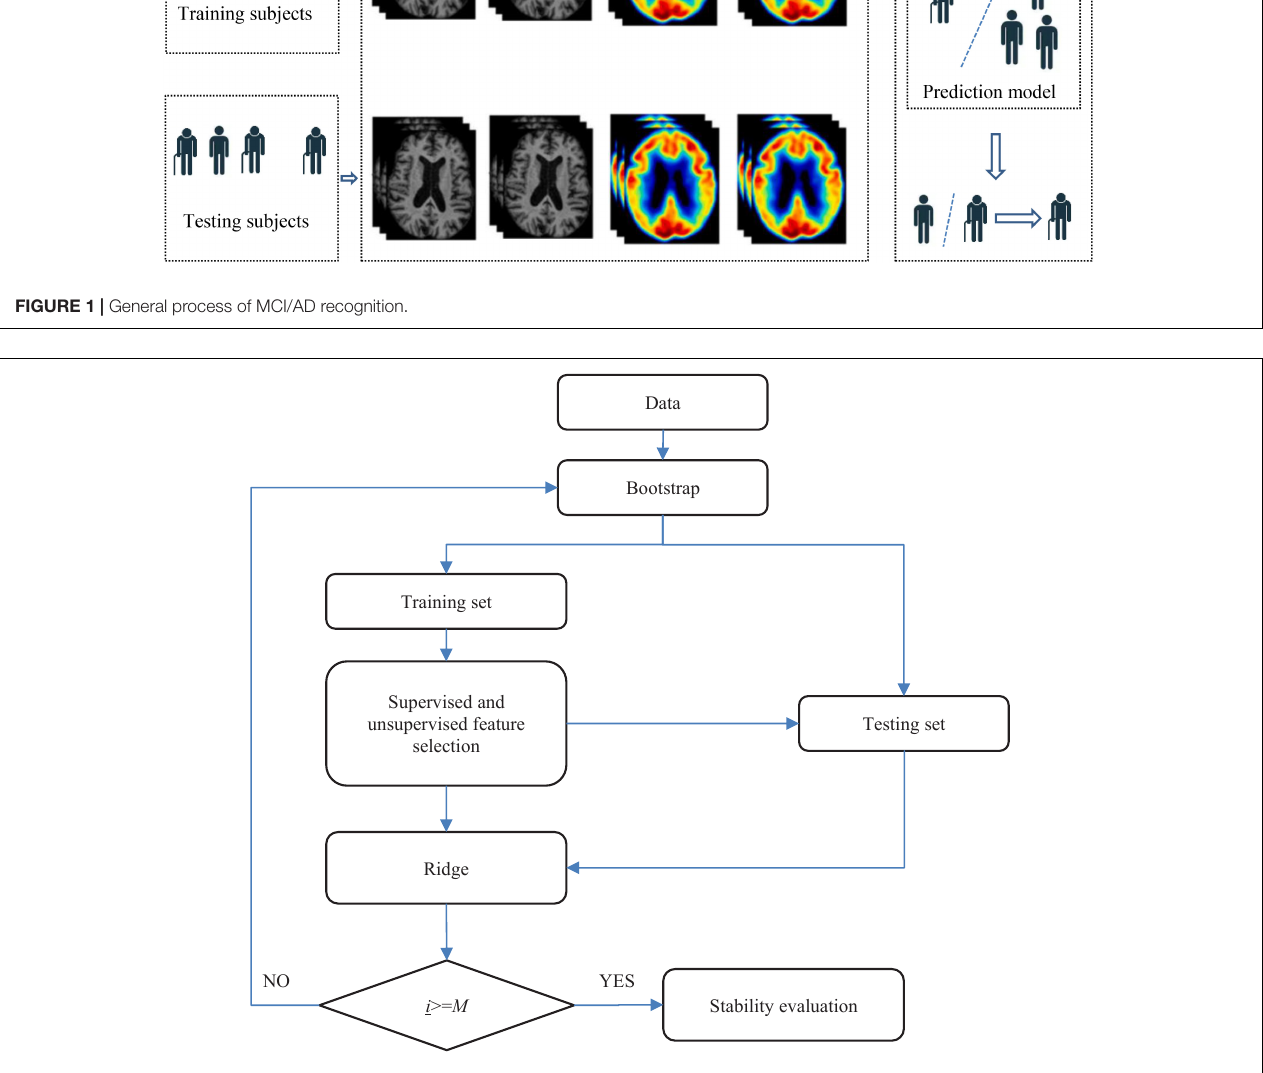
FIGURE 2 | Flow chart for stability